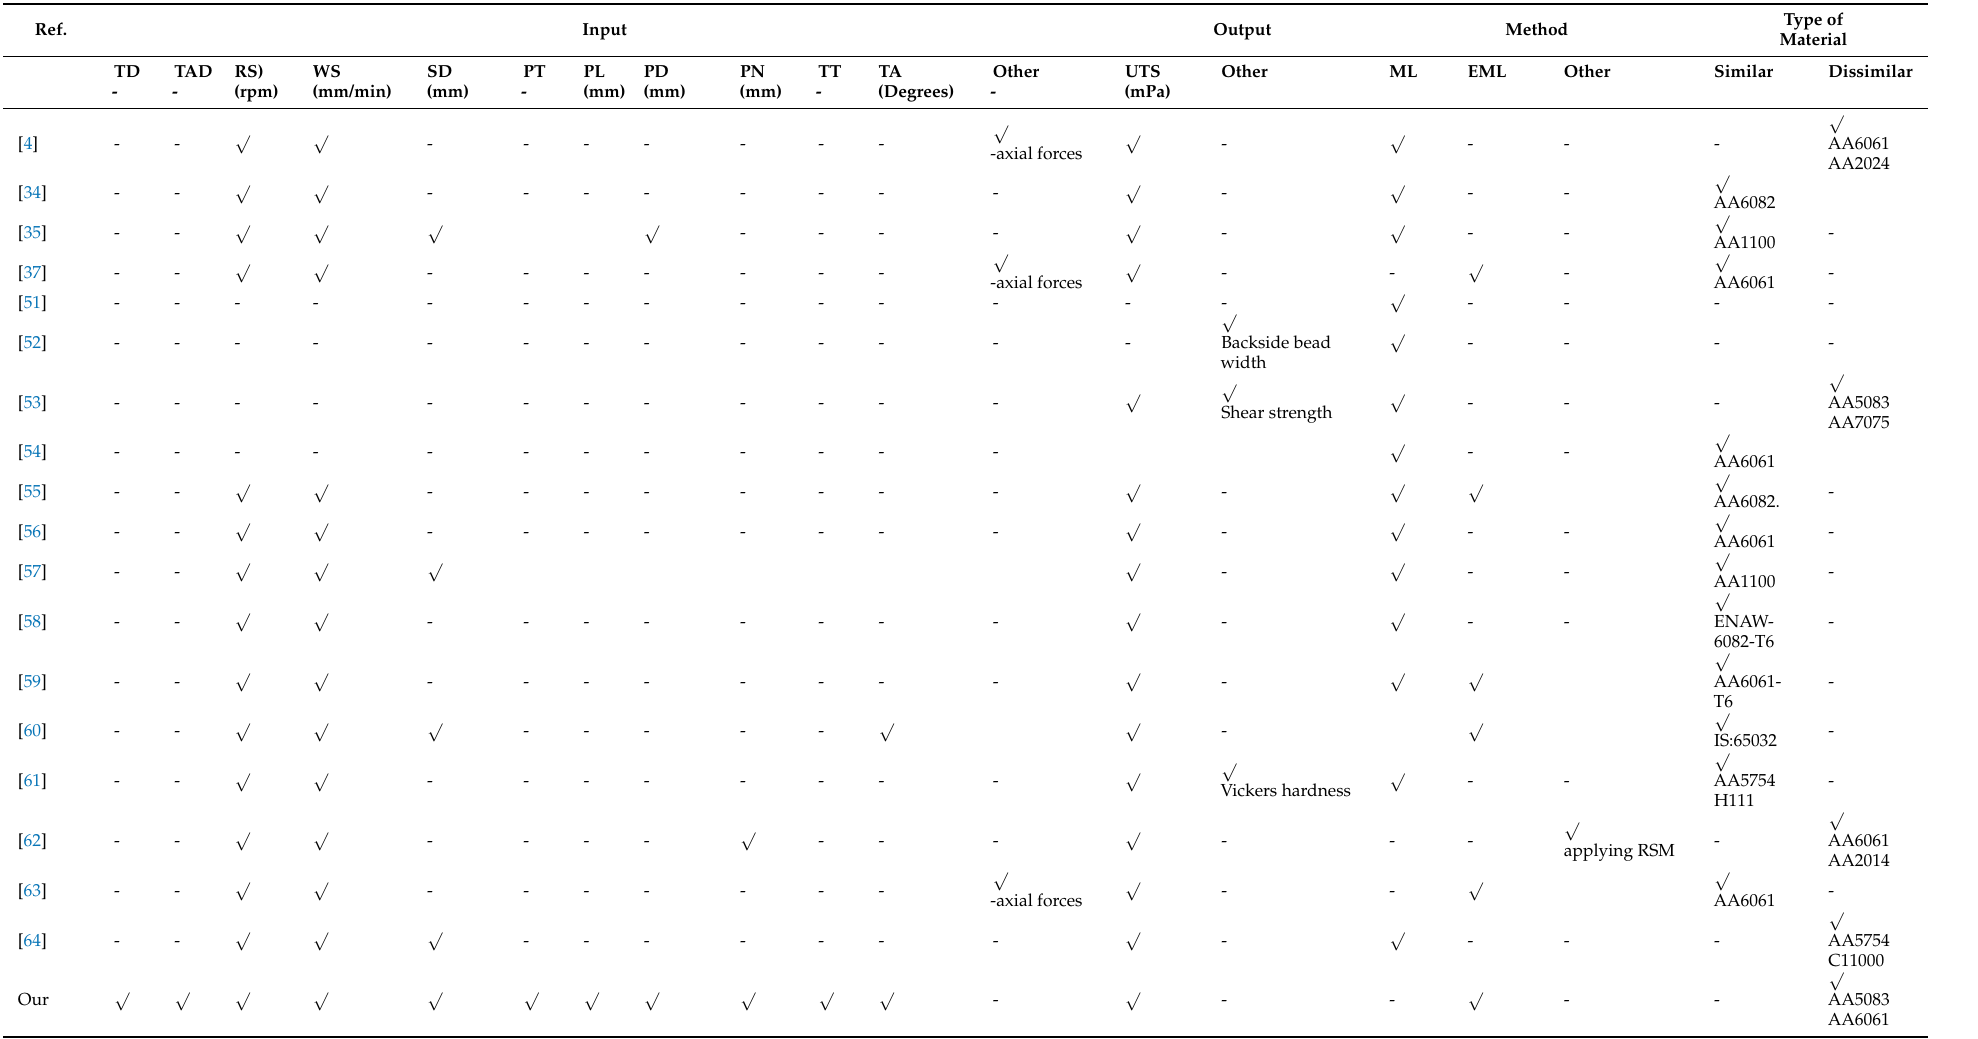
Table 1. Parameters, outputs, methods, and materials used in the previous literature and our